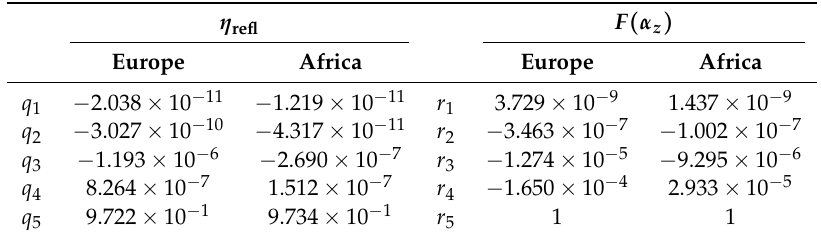
Table 3. Coefficients of the model for the reflectance efficiency η refl in Equation (4) and for the scaling factor F ( α z ) in Equation (5) for Europe as originally reported for Italy in Ref. [24], and those obtained for Africa in the present work.